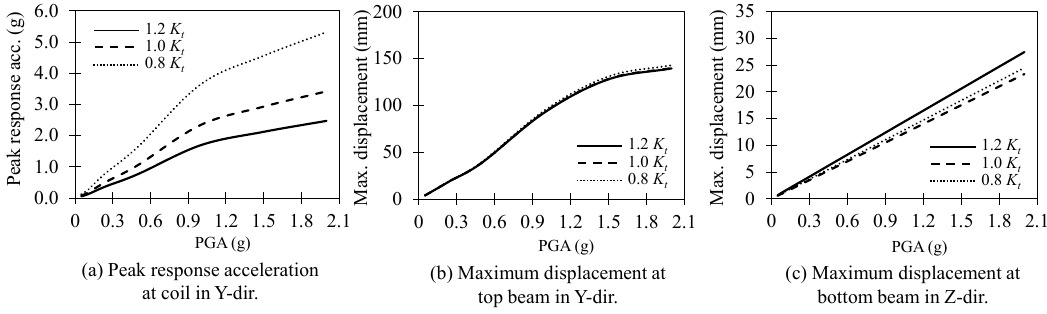
Figure 20. Effect of variation of effective translational stiffness on dynamic responses according to PGA.